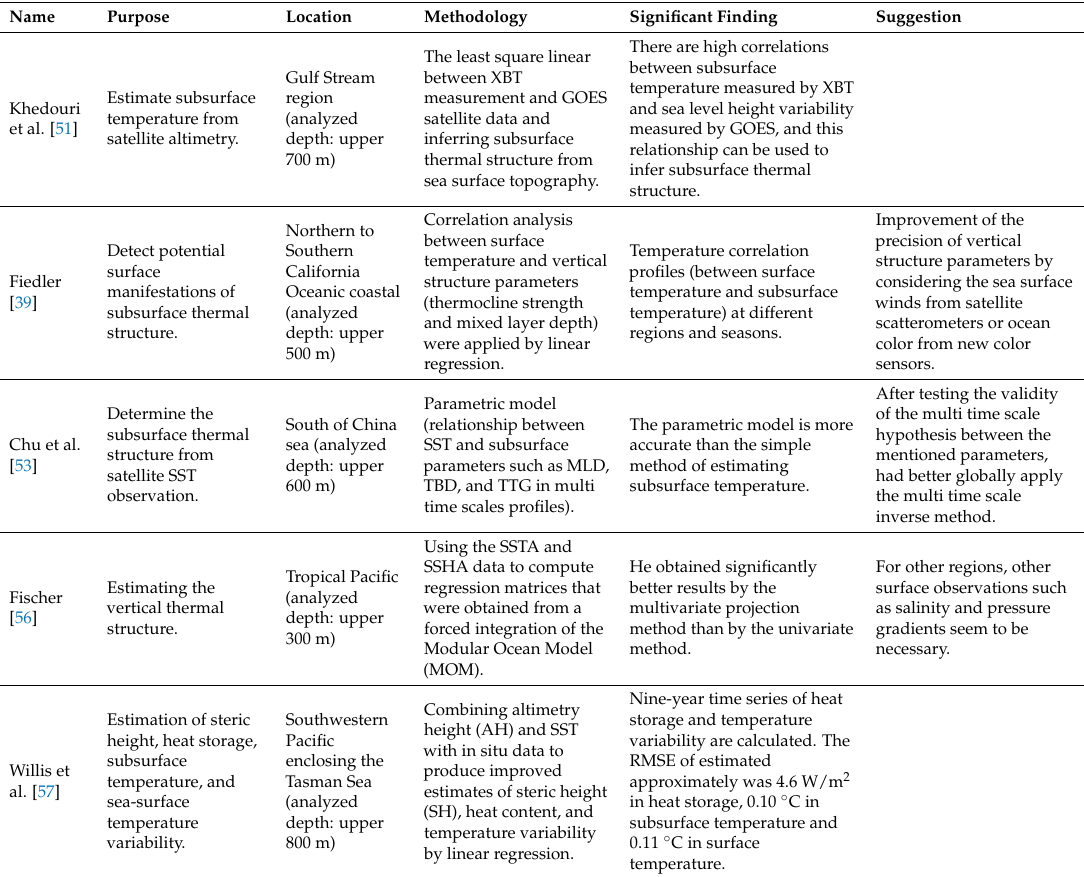
Table 3. Illustration of most studies used to estimate ocean/sea subsurface water temperature using model-based